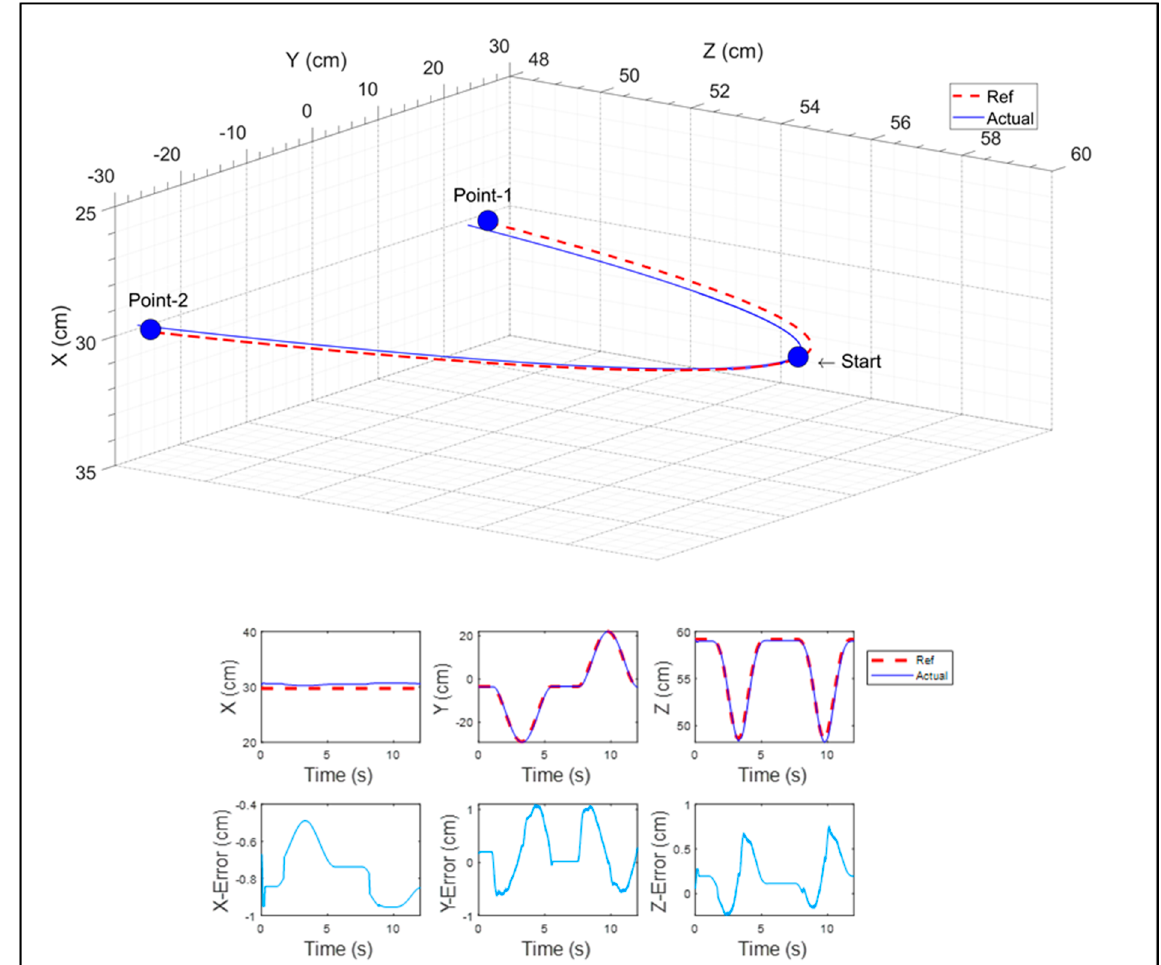
Figure 25. Reaching in the transverse plane.